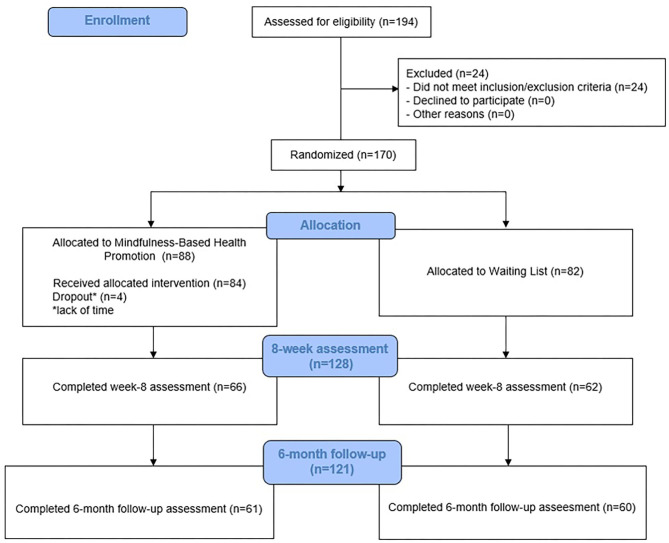
Consort diagram.